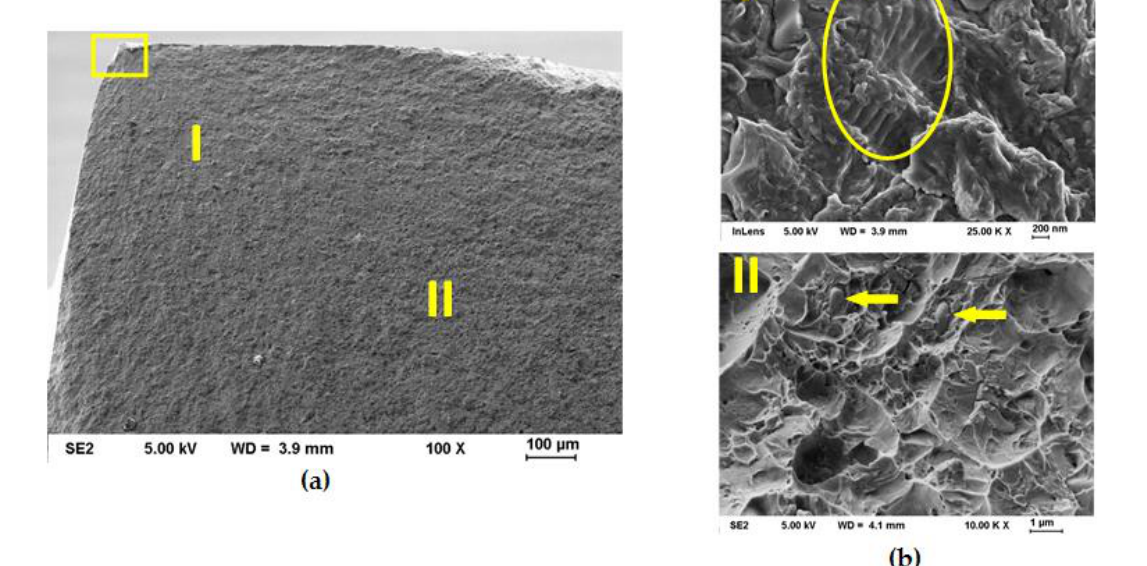
Figure 11. ( a ) Fatigue fracture surface of a QP1 specimen with ( b ) different fracture areas.